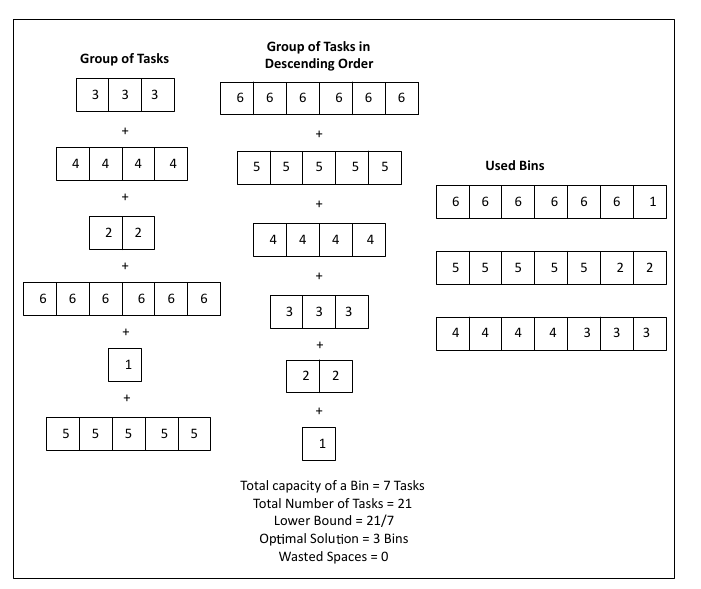
Figure 7. Best Fit